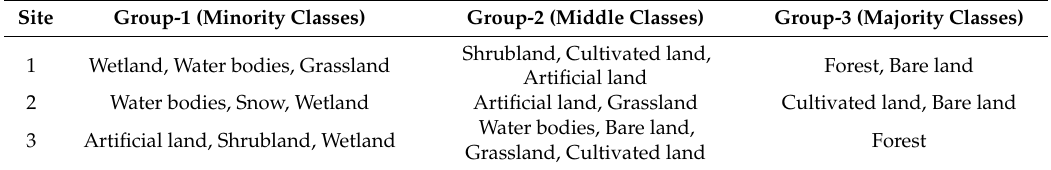
Table 2. Grouping the land cover classes based on the number of samples over each experiment